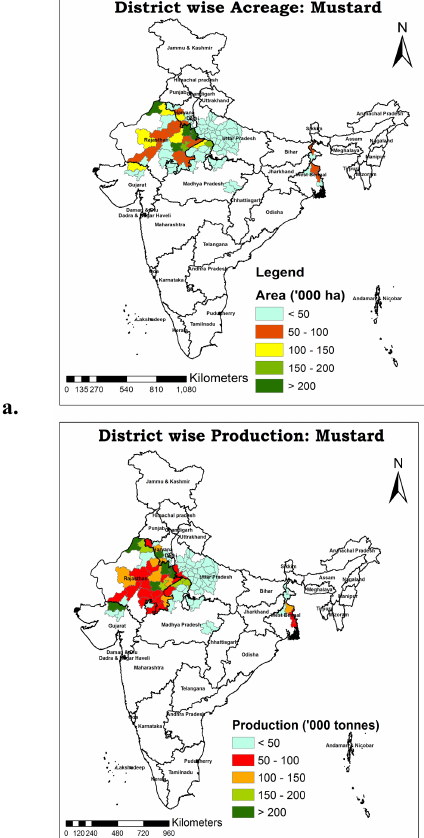
Figure 3. District-wise average (latest 3 years) contribution to